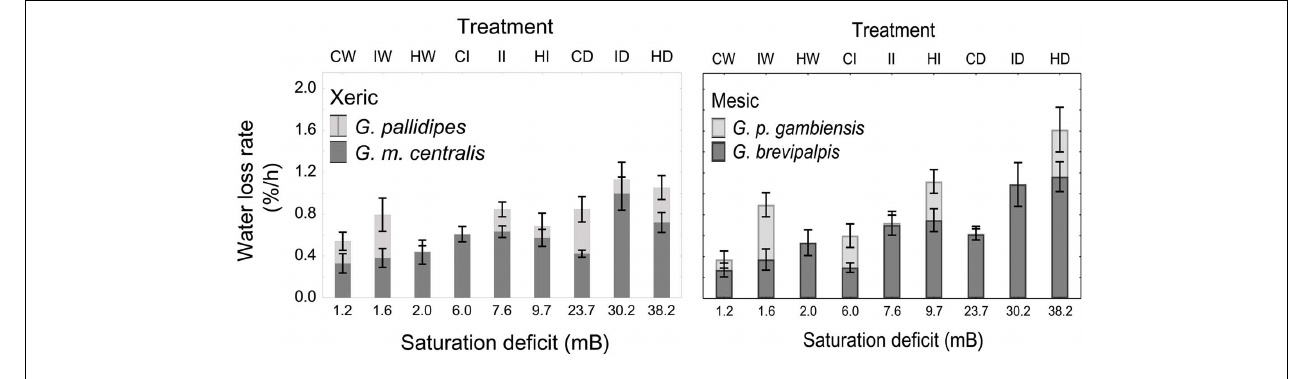
G. palpalis gambiensis . Treatments and corresponding saturation deficits (in mB) include the following temperature (in ˚C), relative humidity (in %) combinations: 21,99 (CW); 25,99 (IW); 29,99 (HW); 21,76 (CI); 25,76 (II); 29,76 (HI); 21,0 (CD); 25,0 (ID); and 29,0 (HD) where C, cold;W, wet; I, intermediate; H, hot; and D, dry.